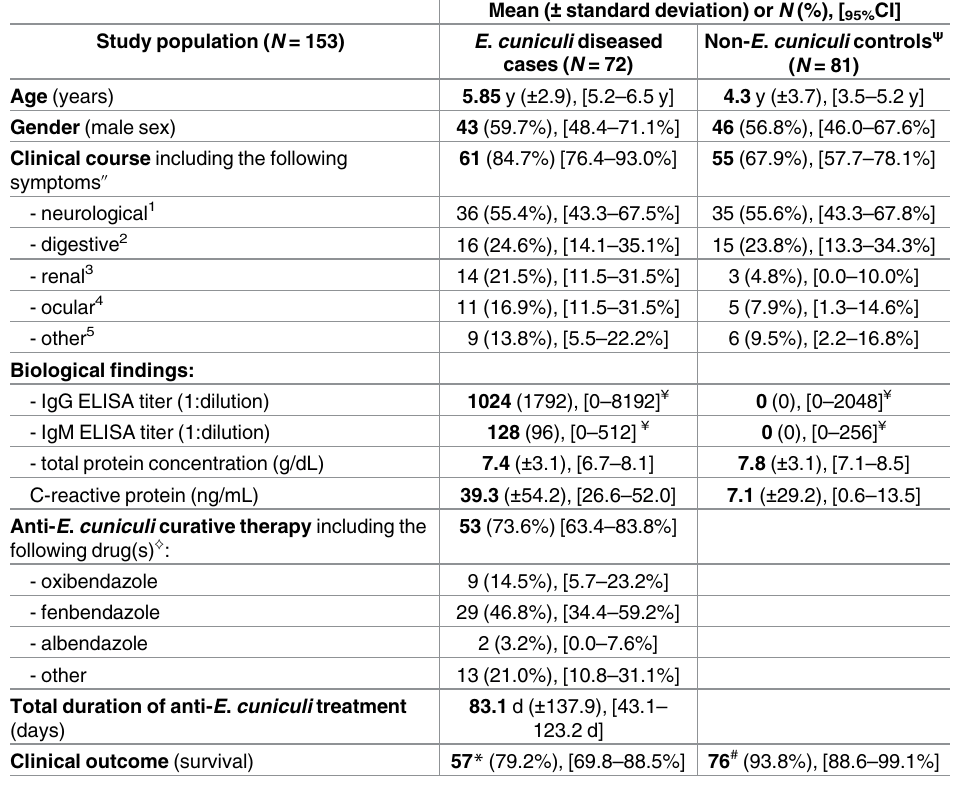
Table 1. Overall characteristics of the included rabbit patients in the final cohort. The group assign- ment was made accordingto the method reportedin the Material& Methods section